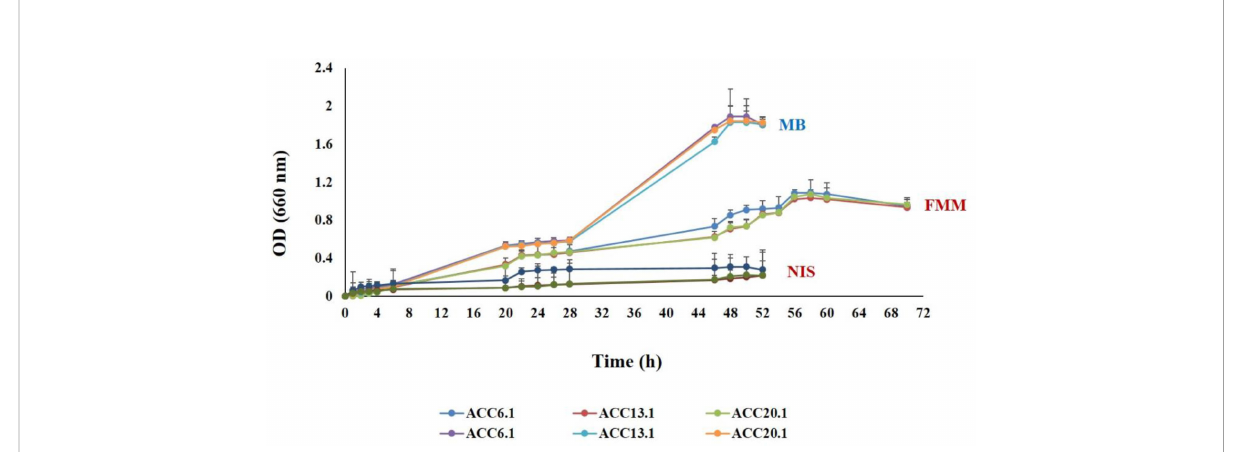
FIGURE 2 Comparative study to evaluate the bacterial growth curve of T. maritimum strains ACC20.1, ACC13.1, and ACC6.1 recovered from a Portuguese Senegalese sole farm following cultivation on marine broth (MB), marine broth treated with a ten-fold dilution of a detergent Igepal CA-630 (NIS), and Flexibacter maritimus broth (FMM). Data obtained from Abdelaziz (2016). Optical density (OD) readings were taken every 2 hours of incubation at 28°C and were performed in duplicate for each strain at 600